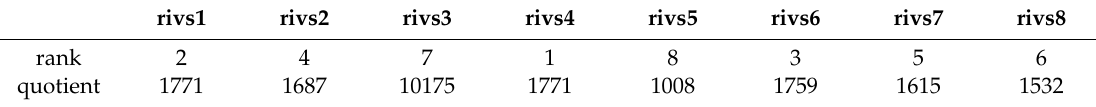
Table 1. A rtificial neural network (ANN) model responses to input values. Table 1. Artificial neural network (ANN) model responses to input values.